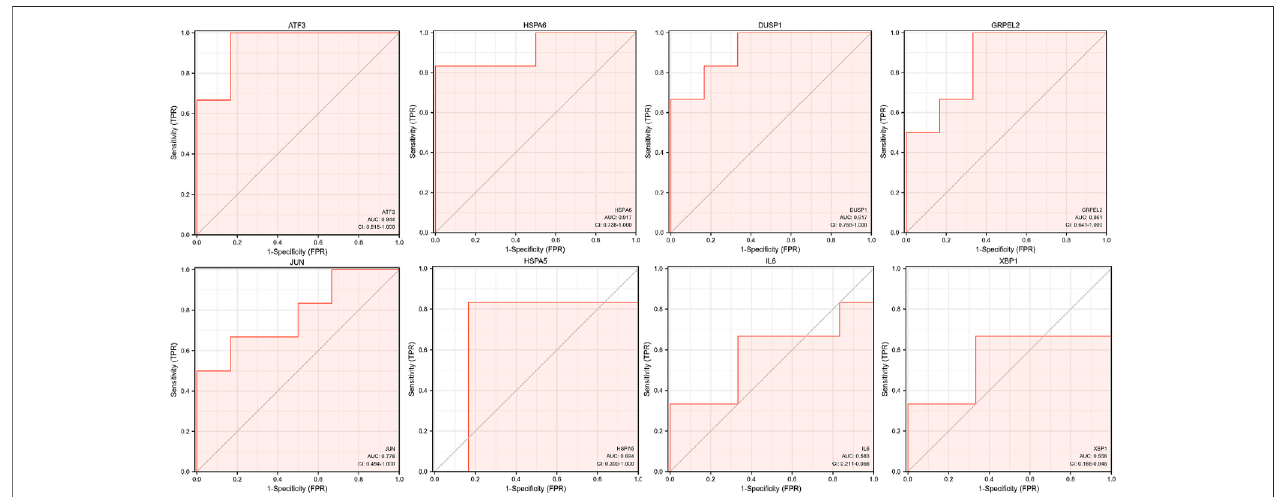
FIGURE 9 | The ROC curves of eight hub genes.